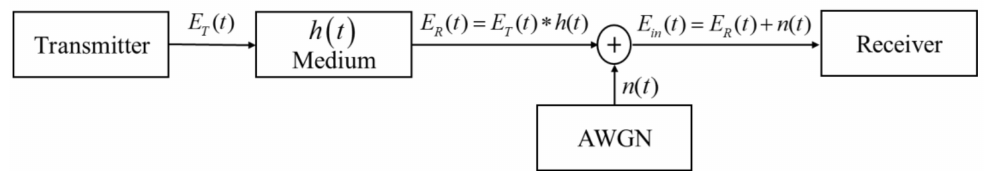
Figure 1. Block diagram of a wireless link operating in the millimeter